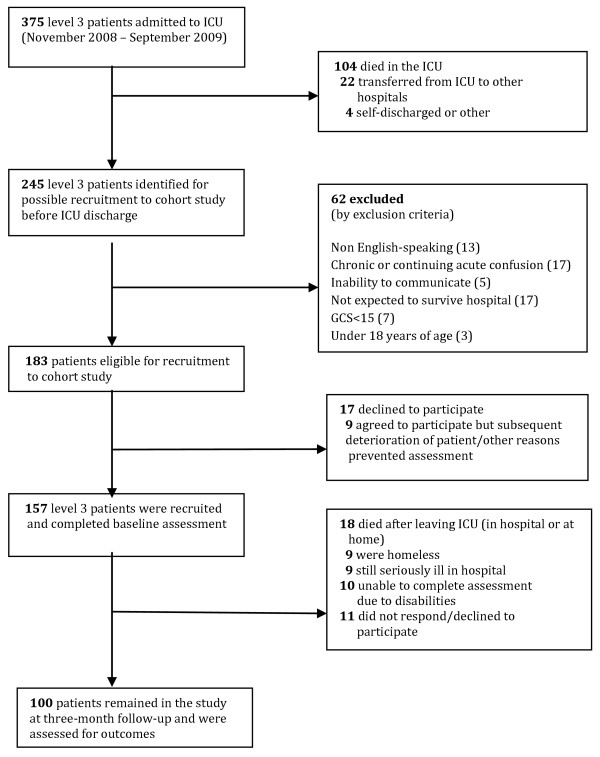
Flow diagram of patient recruitment and participation in a cohort study of psychological outcomes of intensive care survivors.